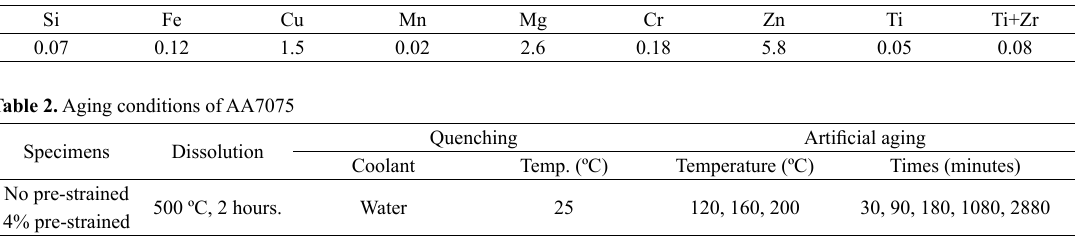
Table 1. Chemical composition of AA7075 (in wt. %)